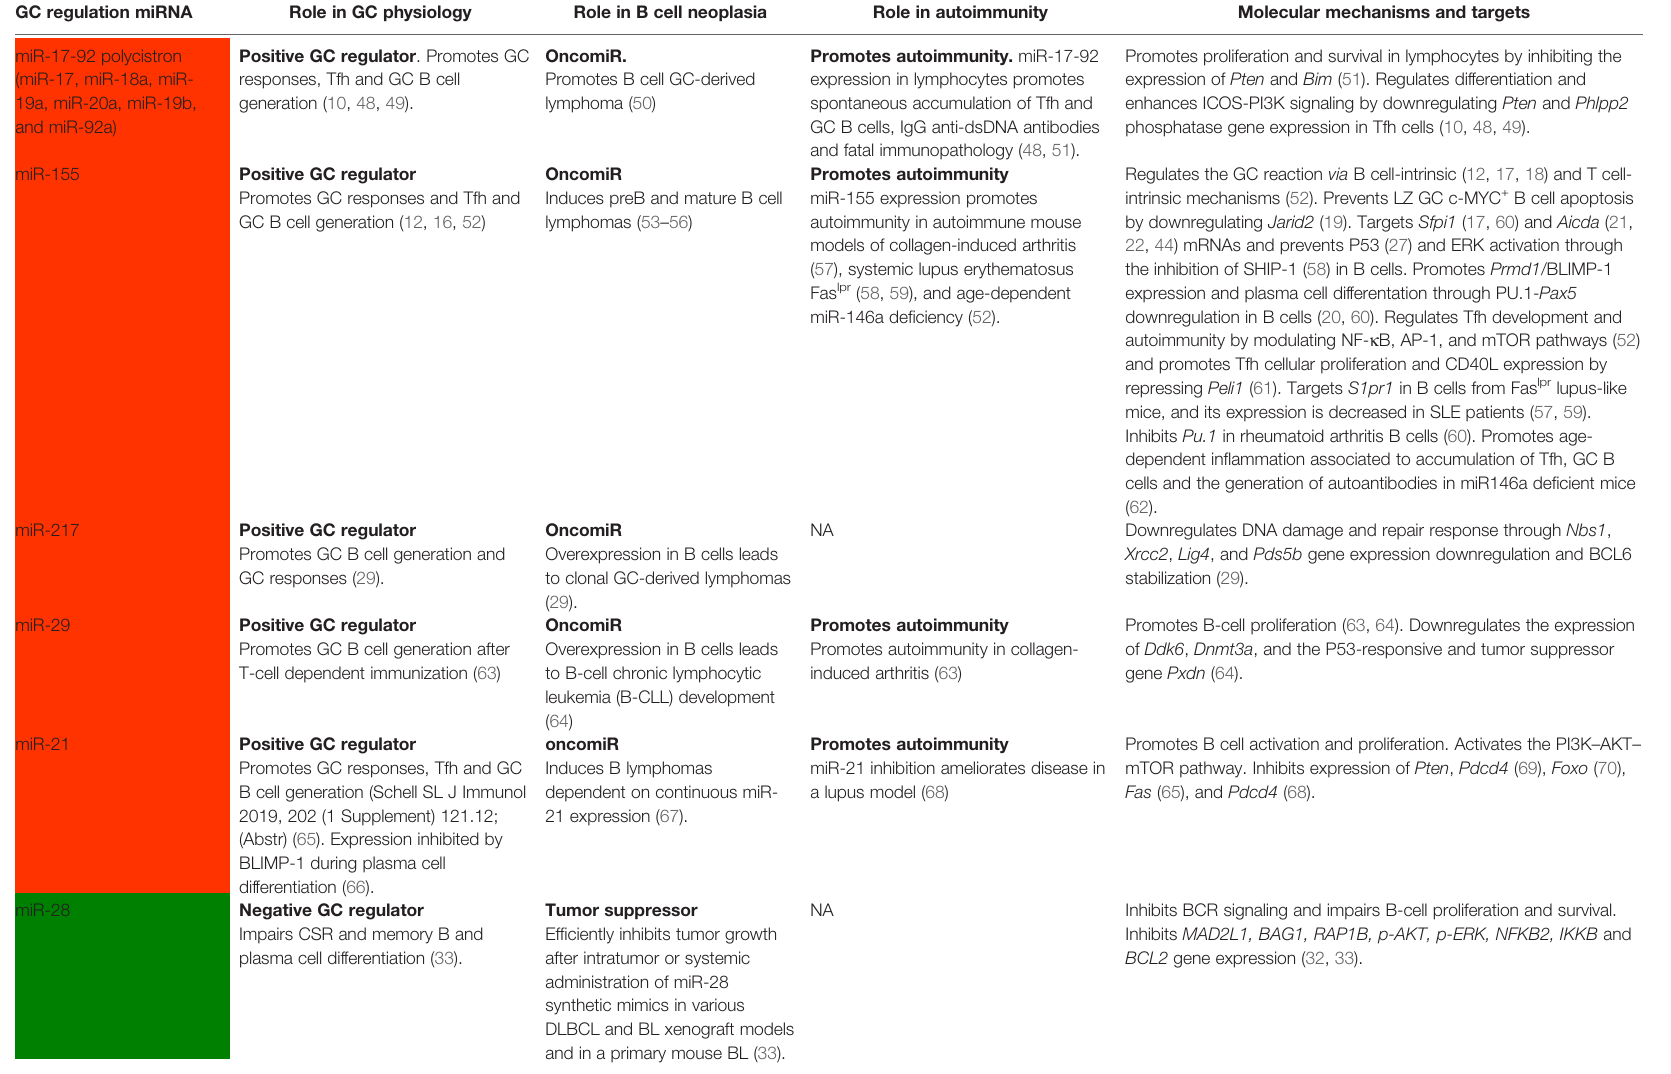
TABLE 1 | Identi fi ed roles of miRNAs in the regulation of physiological GC responses and in GC-derived